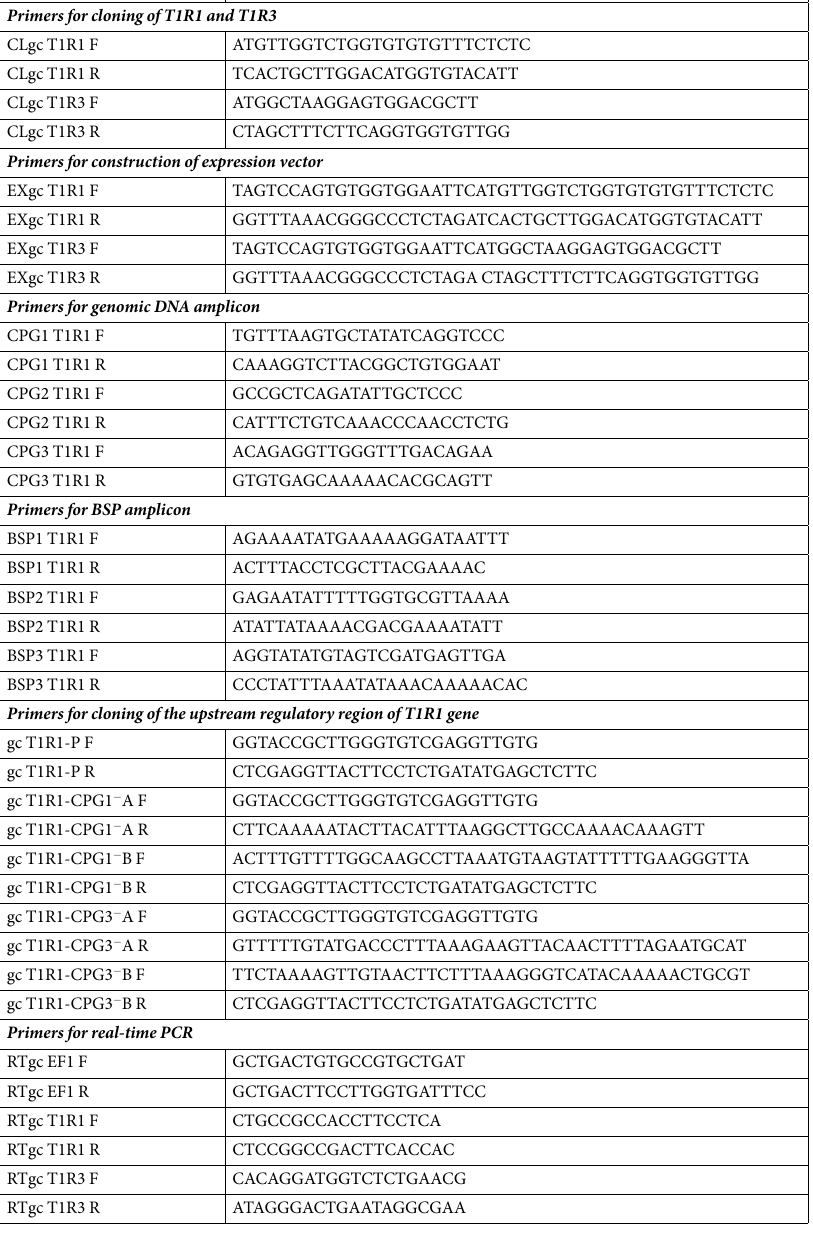
Table 7. Nucleotide sequences of the Statistical analysis. The normality of data was assessed by using SPSS 19.0 software with the Shapiro-Wilk test. All data of T1R1 and T1R3 gene expression levels were subjected to one-way analysis of variance using SPSS 19.0 software. Differences between the means were tested by Duncan’s multiple range test after the homogeneity of variances was checked. The DNA methylation analysis was determined with the χ 2 test. Statistical significance was determined at the 5% level. All data were presented as the mean ± S.E.M (standard error of the mean).